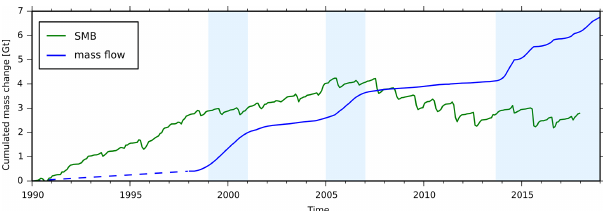
Figure 12. Cumulated mass flow through a cross section of Har- ald Moltke Bræ close to the terminus (blue) and monthly cumu- lated SMB (green) summed over the drainage basin. The surges are marked by light blue